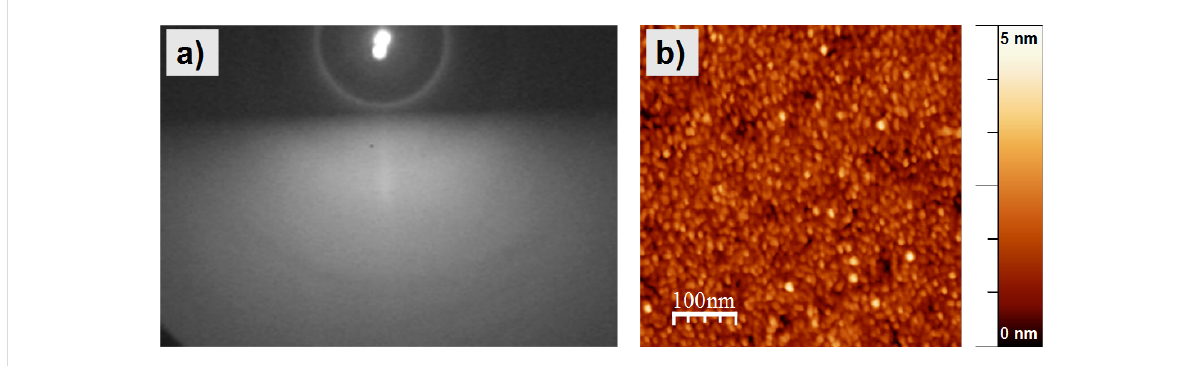
Figure 2: 3 nm thick FePt film on SiO 2 /Si(001) substrate after annealing at 650 °C for 30 min: (a) RHEED pattern taken at an electron beam energy of 25 keV delivering just a diffuse intensity distribution without any superposed streaks or spots (the bright ring around the direct beam spot is a halo fea- ture resulting from the RHEED arrangement). (b) AFM image of the FePt film revealing its grainy structure leading to a RMS roughness of 0.6 nm.